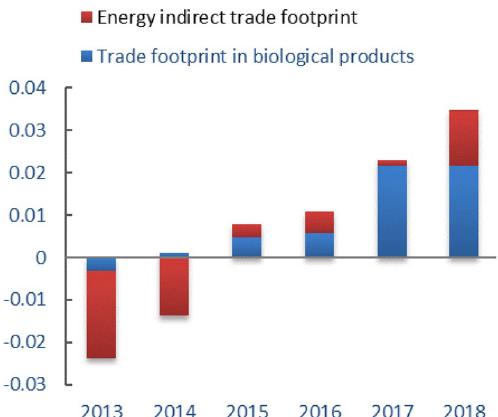
Figure 10. The per capita trade footprint of Guangdong Province from 2013 to 2018.